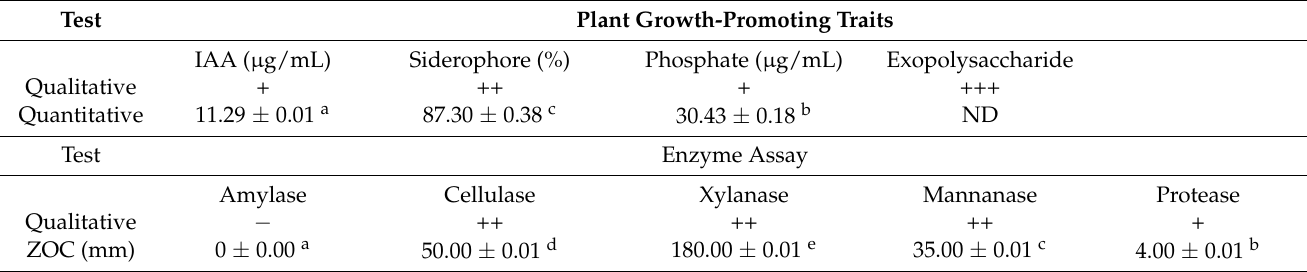
Table 1. Plant growth-promoting features of B. cereus T4S.